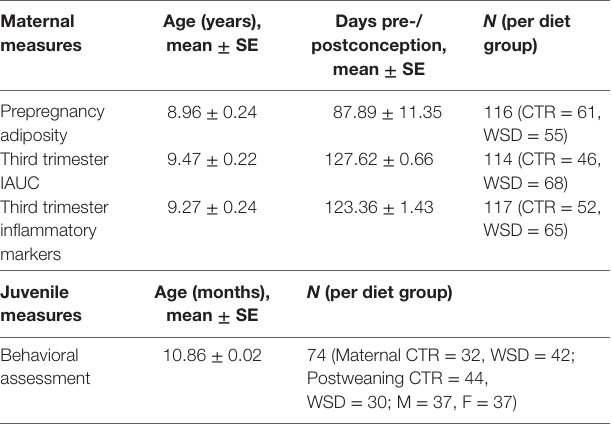
TaBle 1 | Animal numbers and ages for